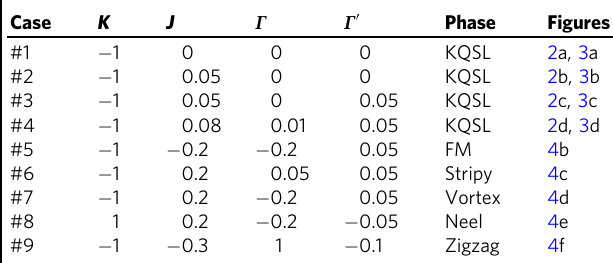
Table 1 Parameter sets for exact diagonalization and spin wave